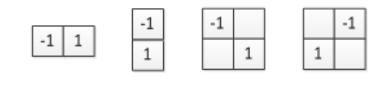
Fig.4 Gradient operators in